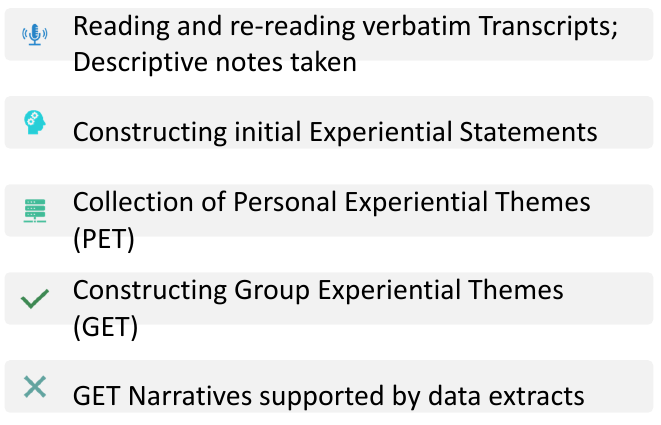
Figure 1. Process of data analysis.